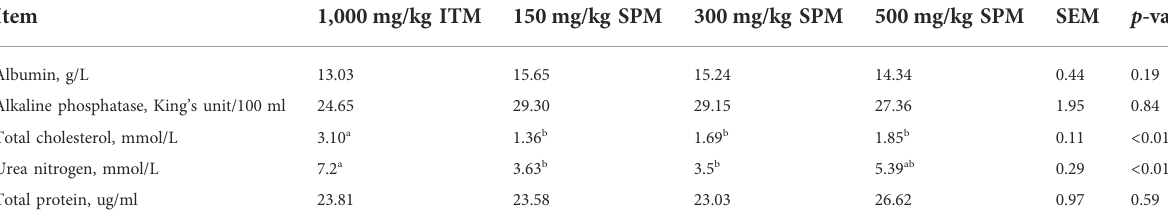
TABLE 5 Effect of supplementation of ITMs and SPMs in basal rations on serum biochemical of